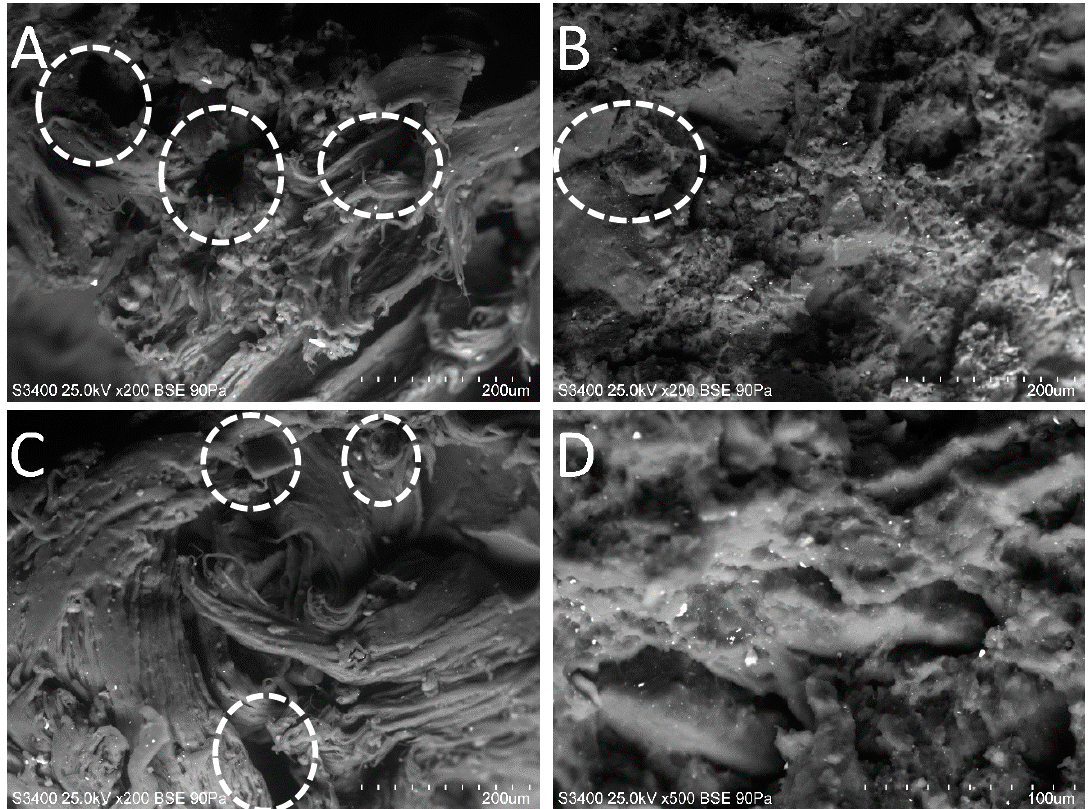
Figure 10. SEM images of surface after tensile test: ( A )—RR: PCL(6800) 50:50; ( B )—RR:PCL(6800) 90:10; ( C )—RR:PCL(FB100) 50:50; ( D )—RR:PCL(FB100) 90:10.